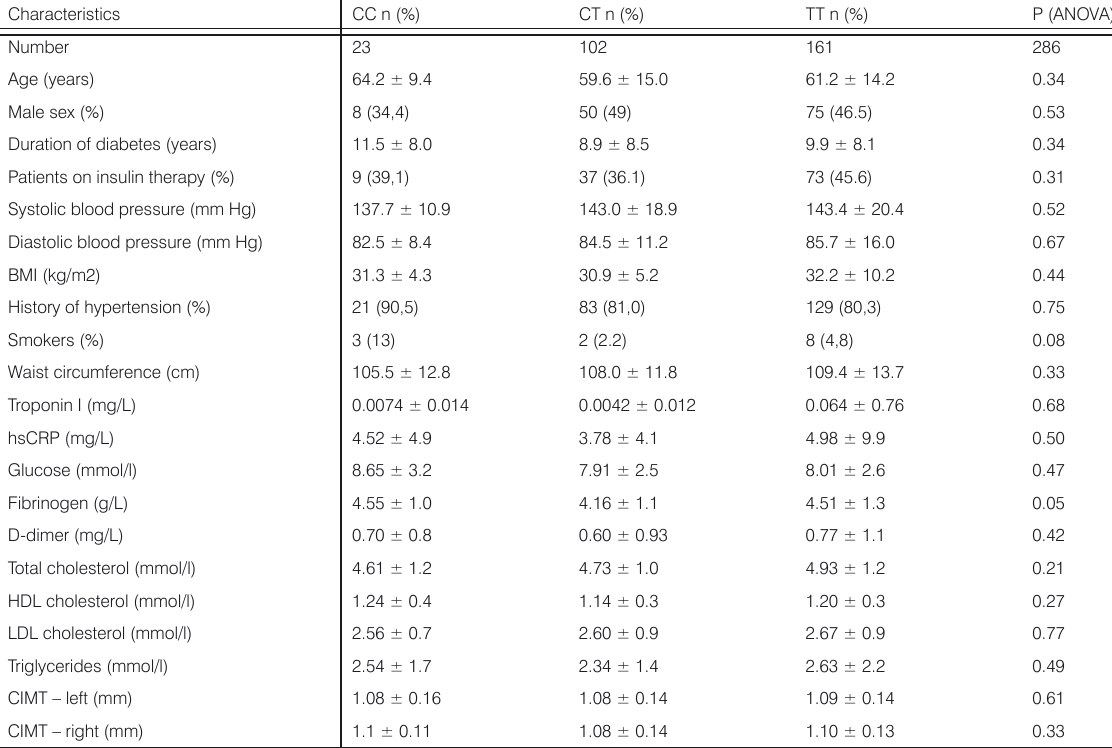
Table 1. Characteristics of patients with type 2 diabetes according to catalase